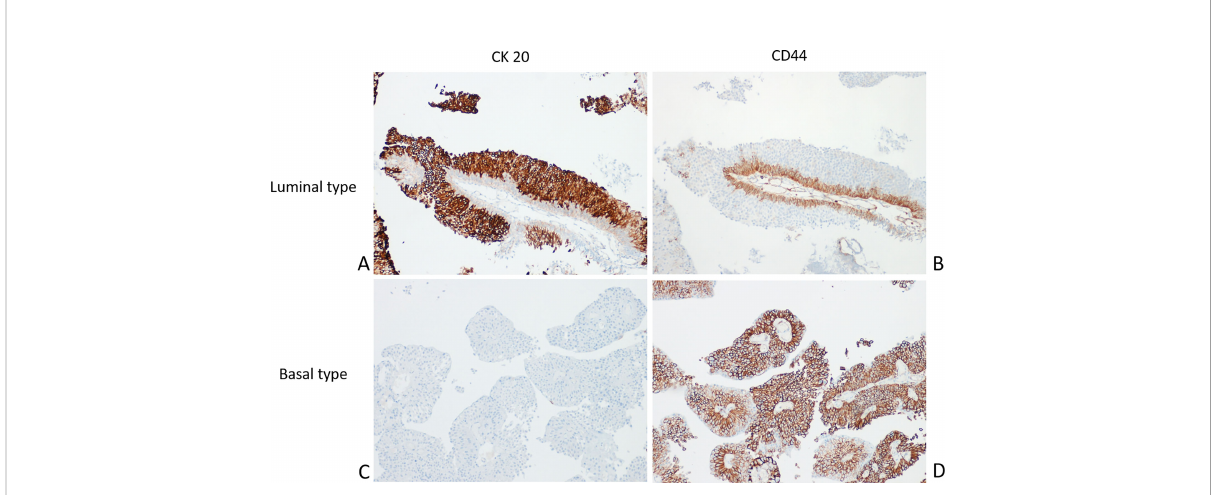
FIGURE 2 Molecular phenotyping with immunohistochemistry in NMIBC. A prototypical example of Luminal type urothelial carcinoma (UC) with the Luminal marker CK20 (A) expressed in almost all tumor cells; in contrast, the Basal marker CD44 is limited to the basal layer (B) . Conversely, a typical Basal type UC showing negativity for CK20 (C) and diffuse CD44 expression (D)